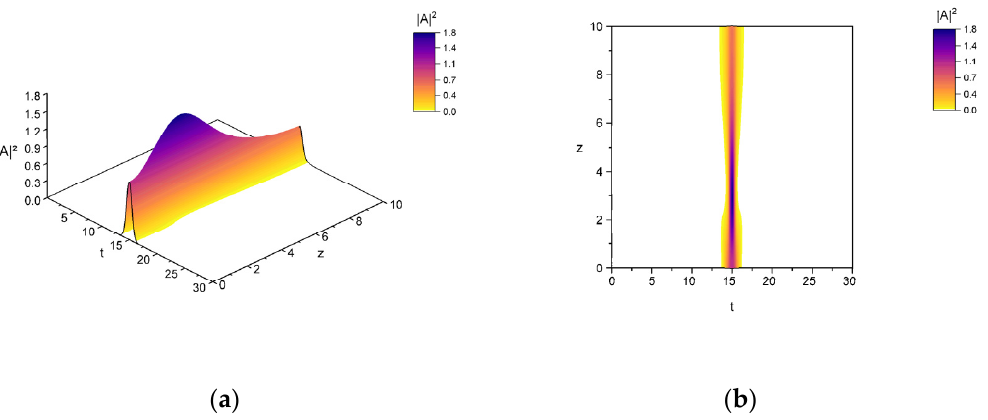
( a ) ( b ) Figure 9. Evolution of the intensity 2 | | A depicted in 3D view ( a ), and on the ( t,z ) plane ( b ) and Figure 9. Evolution of the intensity | A | 2 depicted in 3D view ( a ), and on the ( t,z ) plane ( b ) and computed for the pulse propagation in a nonlinear medium α = 1, δ = 0; parameters ε 1 = 0.01, computed for the pulse propagation in a nonlinear medium 1, 0 α δ= = ; parameters ε 2 = 0.001 in the convergence criterion 0.01, 0.001 ε ε= = in the convergence criterion (28). 1 2